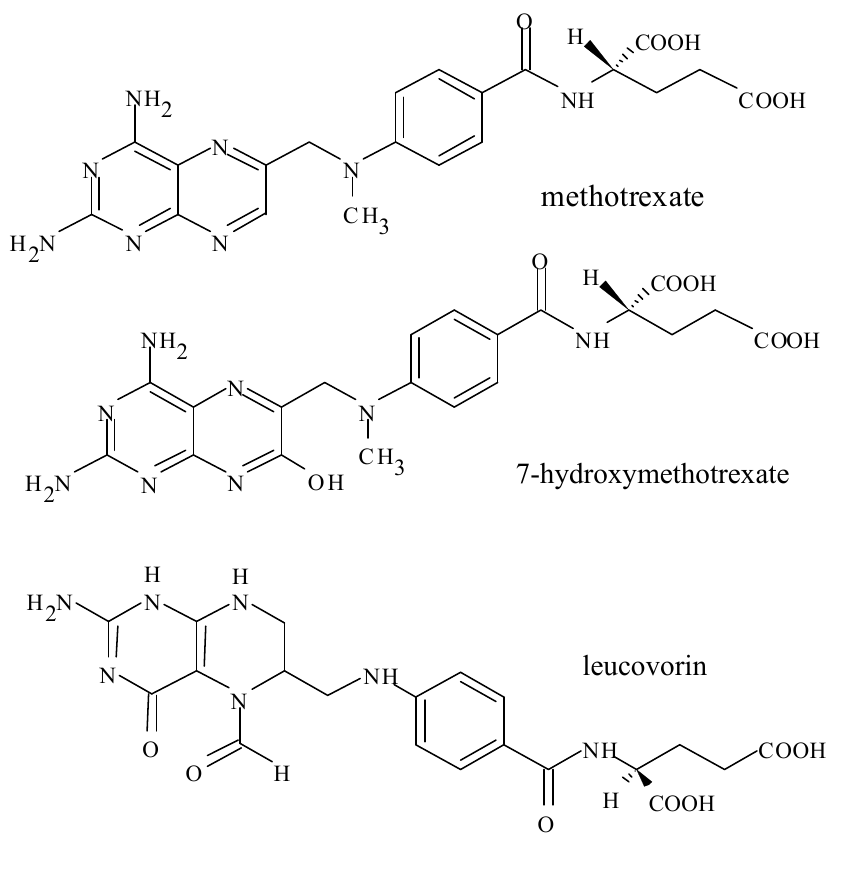
Figure 2. Chemical structures of methotrexate, 7-hydroxymethotrexate and